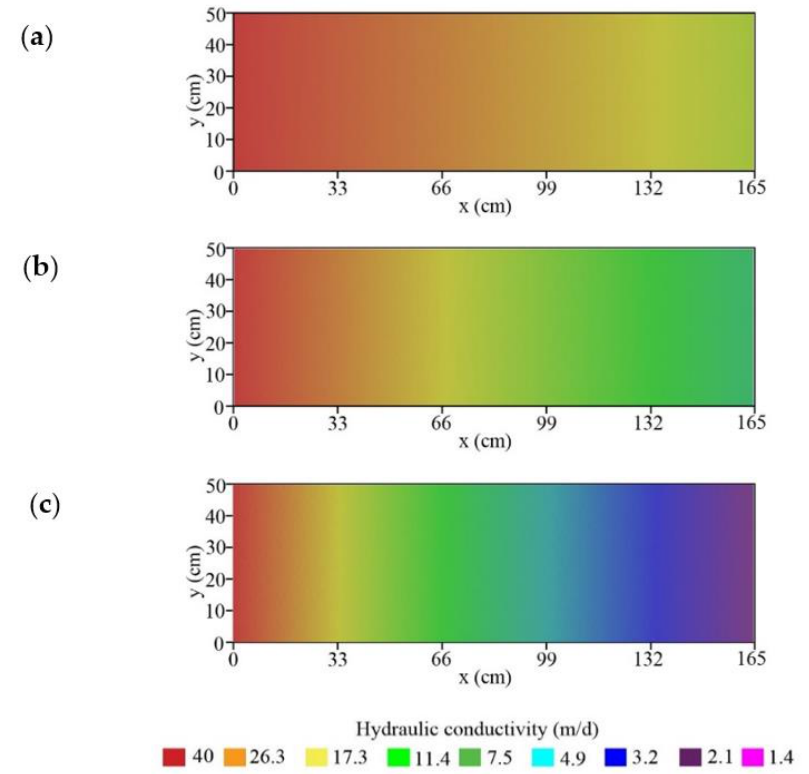
Figure 5. Hydraulic conductivity fields with different length-decay exponents. ( a ) the decay exponent was set to 0.005 m −1 , ( b ) the decay exponent was set to 0.01 m −1 , ( c ) the decay exponent was set to 0.02 m −1 .